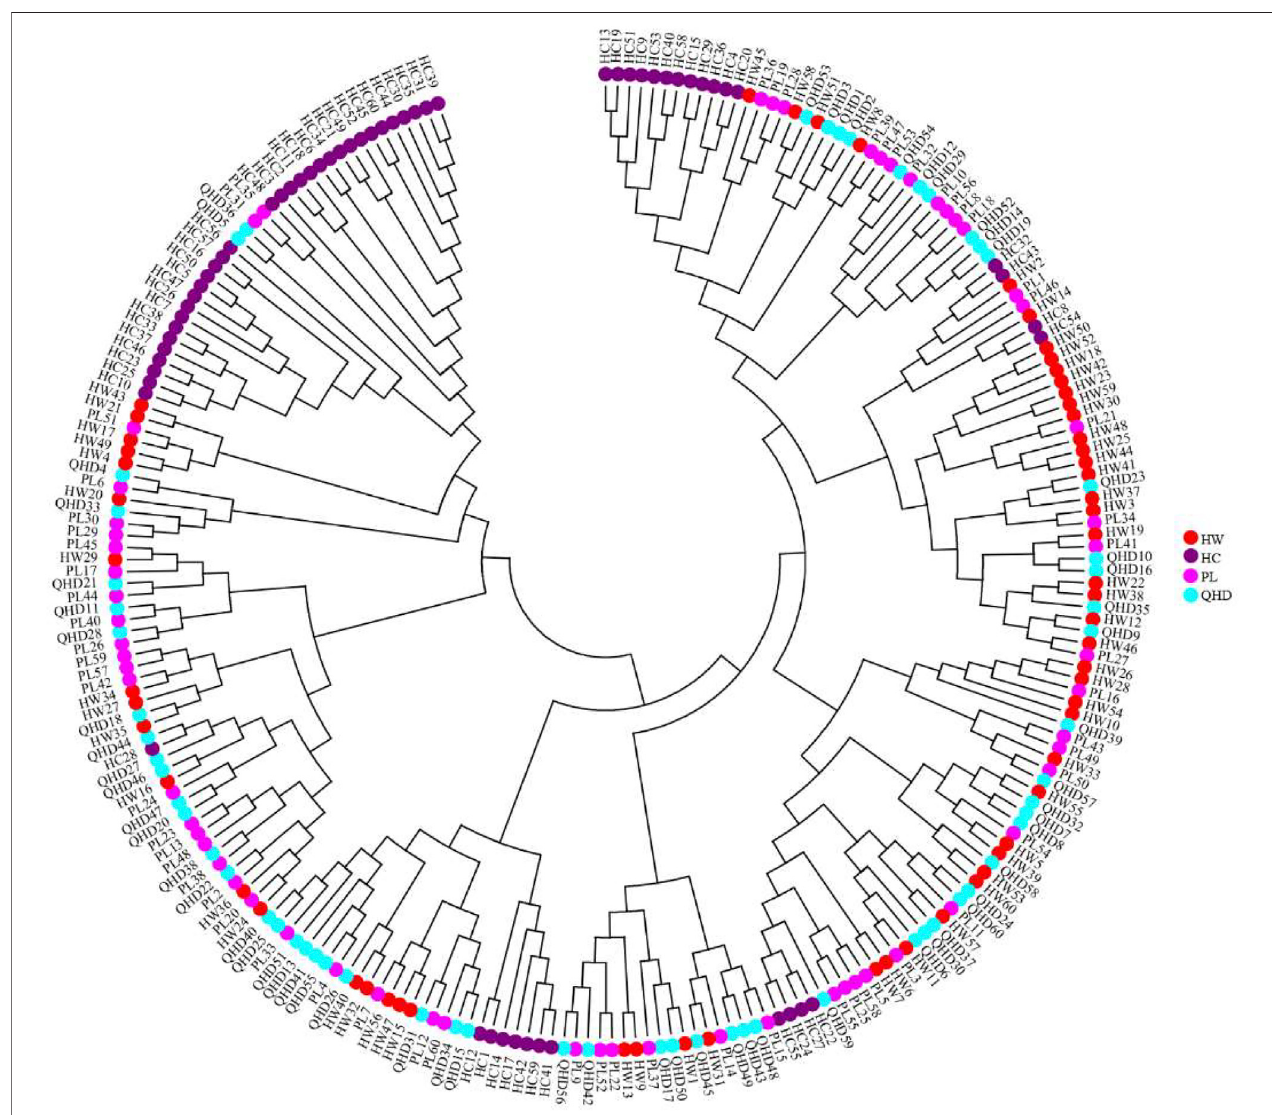
FIGURE 6 | Neighbor-joining phylogenetic tree of 240 individuals of P. trituberculatus based on SSR data.